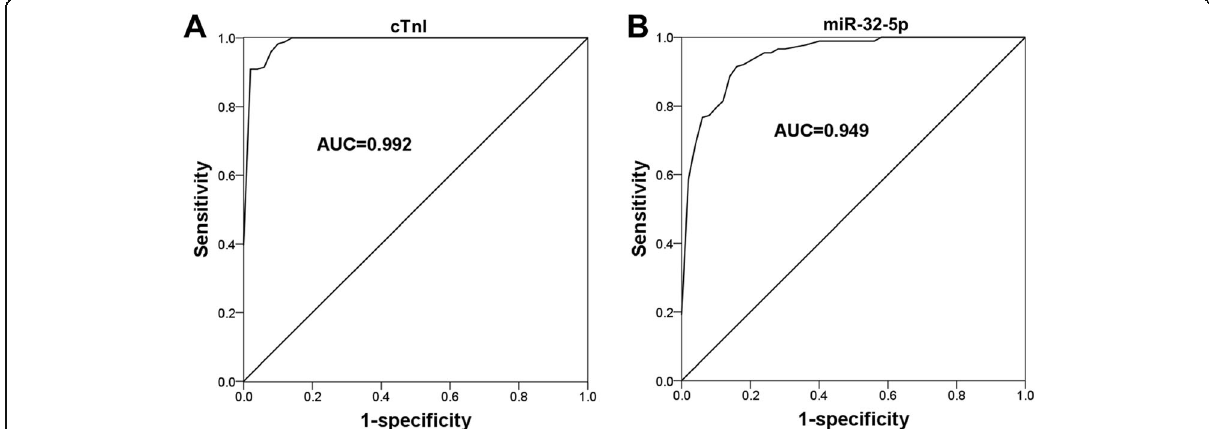
Fig. 3 ROC curves for AMI patients based on cTnI and miR-32-5p. a . A ROC curve based on serum cTnI (AUC = 0.992). b . A ROC curve based on serum levels of miR-32-5p (AUC =